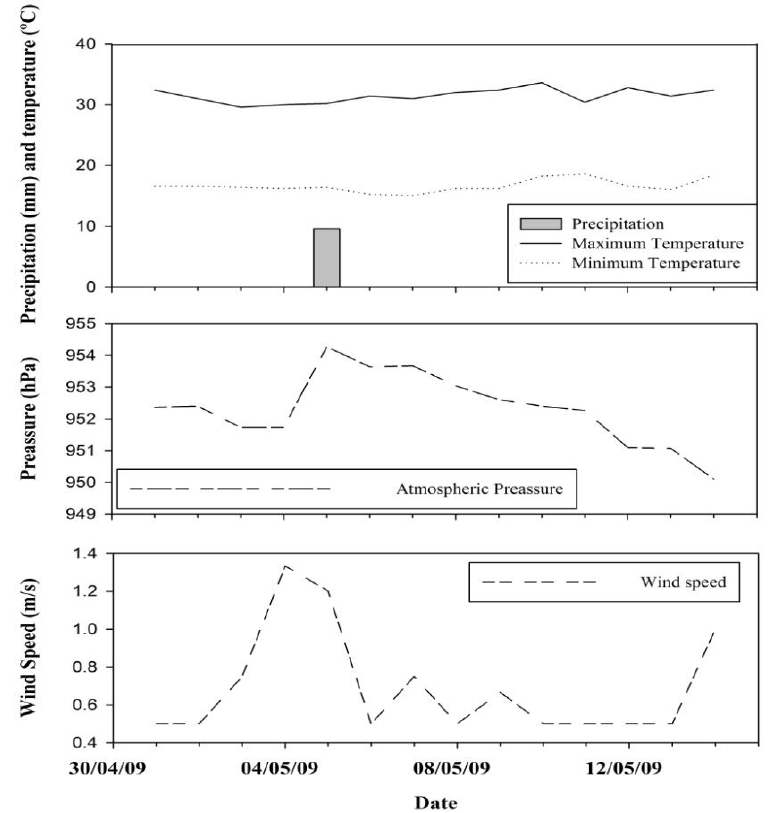
Figure 4. Meteorological variables for the period from 1–14 May.